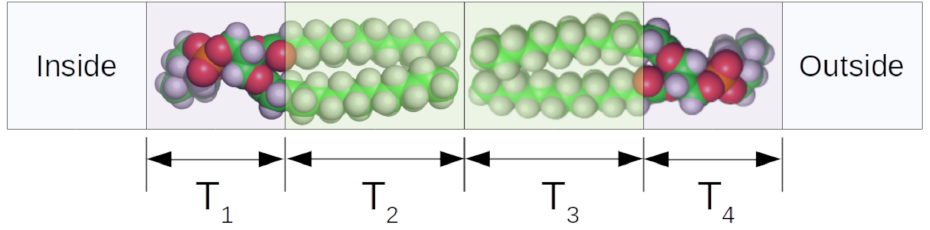
Figure 5. Schematic of a simple four-shell model showing how the four layers correspond to regions of the bilayer. The layer thicknesses are represented by T i . The lipid was rendered using PyMOL 2.5.2